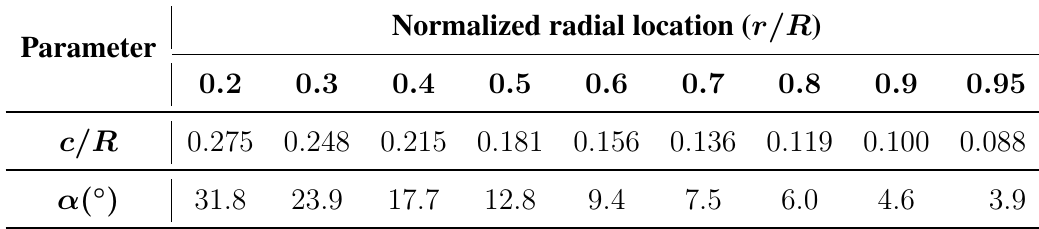
Table 1. Basic geometry of the model wind turbine blades normalized by the rotor radius: c is the chord length, α is the angle with respect to the rotor